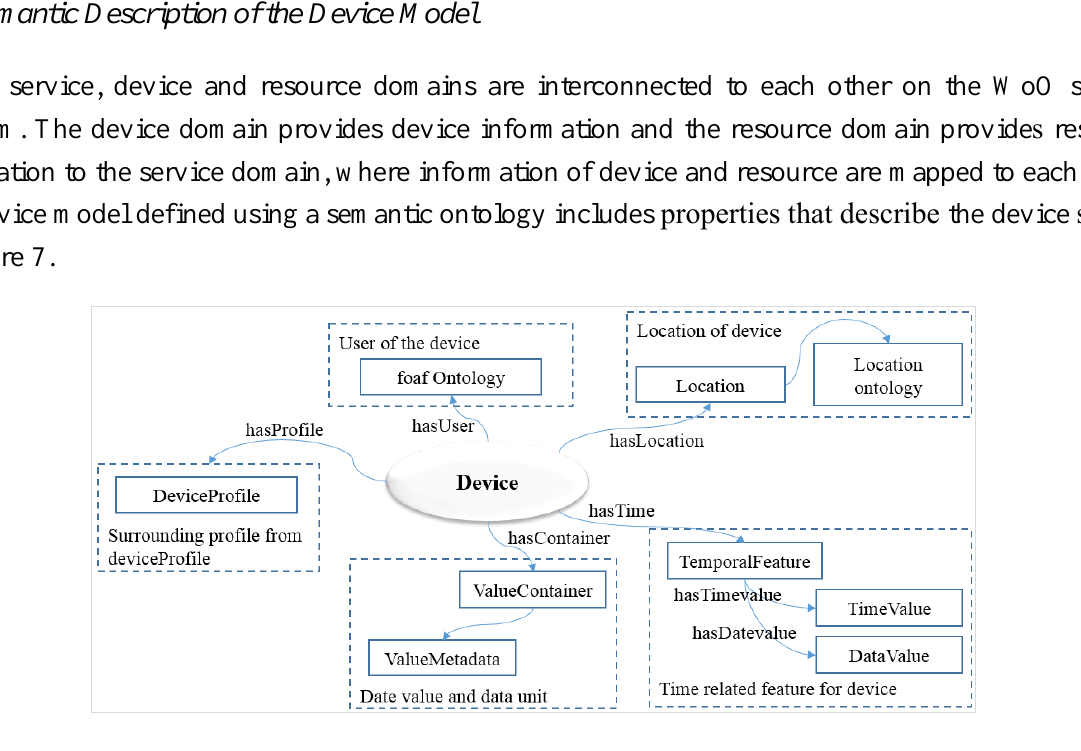
Figure 7. Device model abstracts a physical device using the semantic ontology to provide device profile information to the service